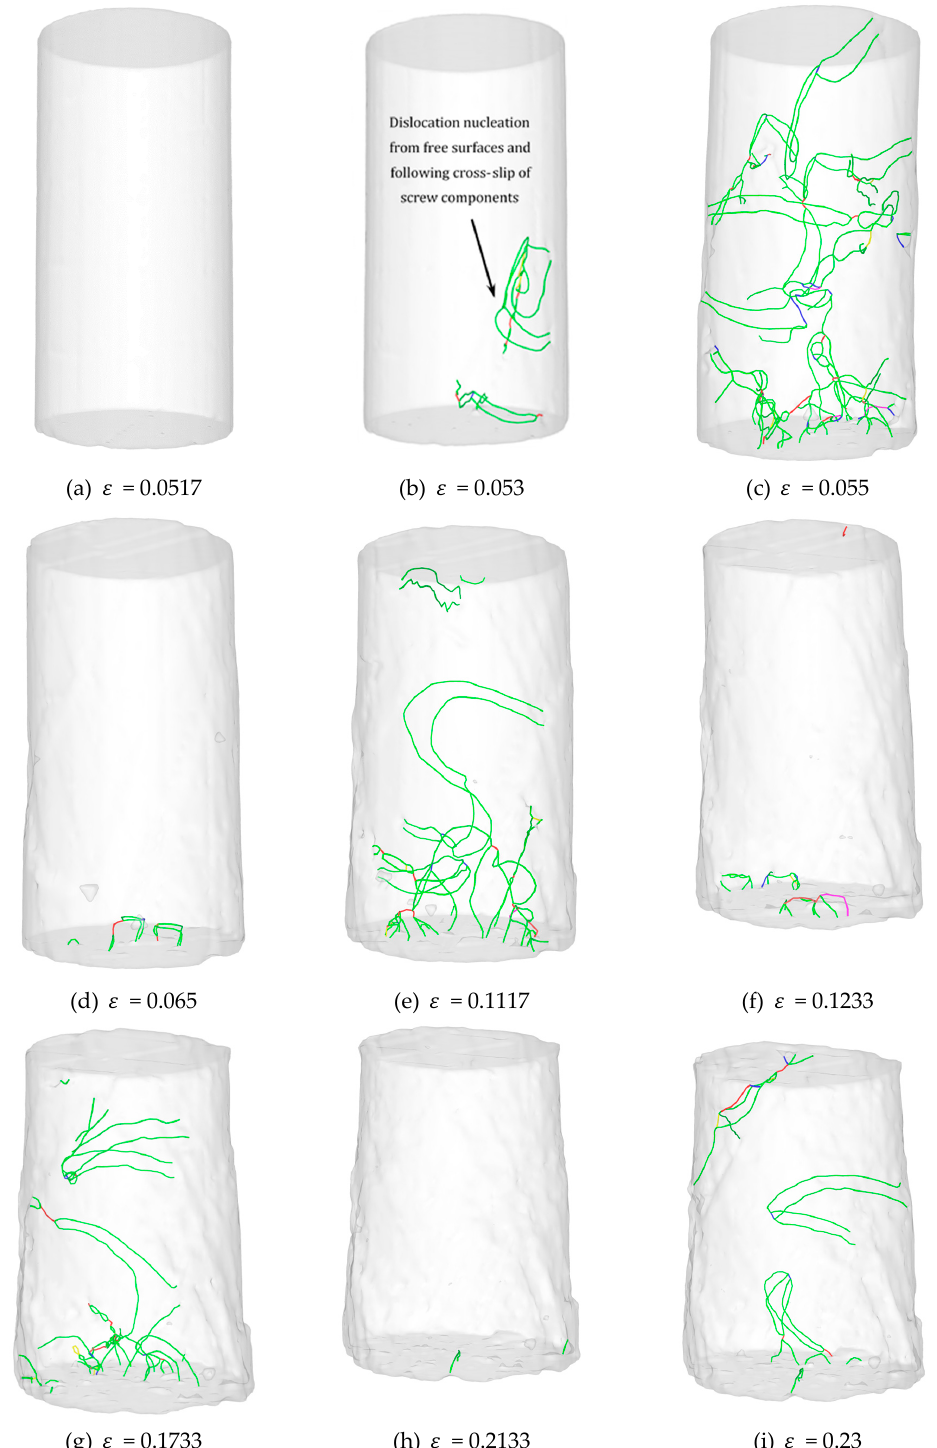
Figure 20. The dislocation network of the pillar with D = 15 nm and H = 30 nm during micropillar compression test at different strains of: ( a ) 𝜀 = 0.0517; ( b ) 𝜀 = 0.053; ( c ) 𝜀 = 0.055; ( d ) 𝜀 = 0.065; ( e ) 𝜀 = 0.1117; ( f ) 𝜀 = 0.1233; ( g ) 𝜀 = 0.1733; ( h ) 𝜀 = 0.2133; ( i ) 𝜀 = 0.23 (after Yaghoobi and Voyiadjis [21]).